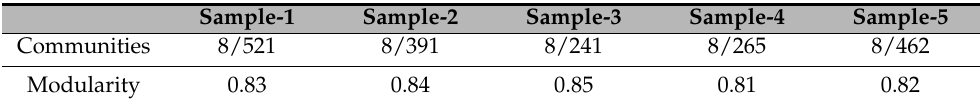
Table 4. Community